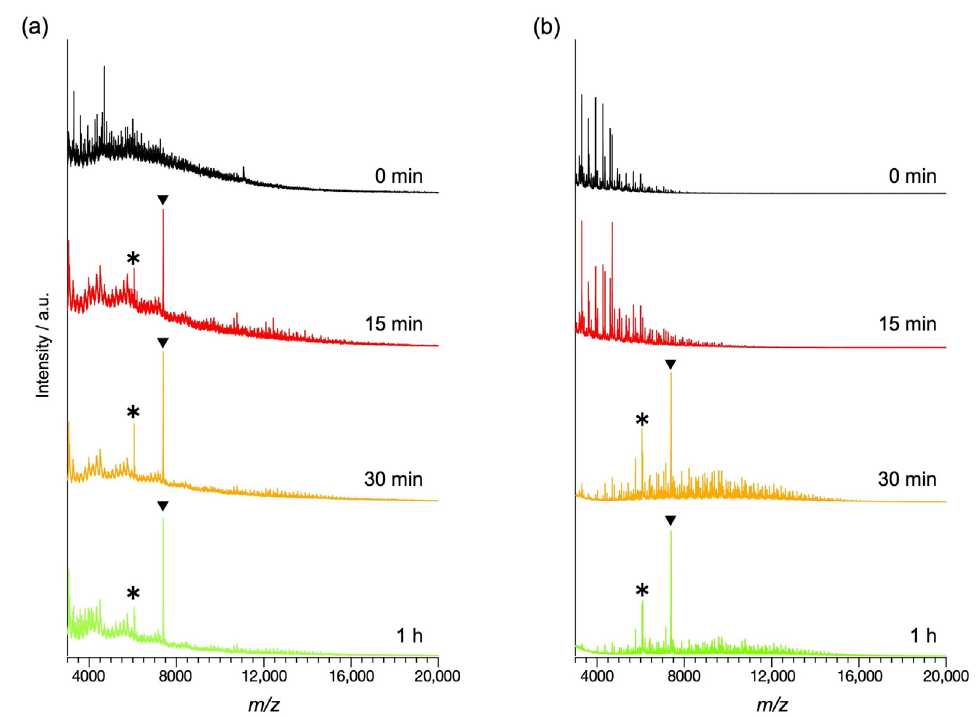
Figure 3. MALDI-TOF-MS spectra during Au 25 PET 18 synthesis ( a ) with TPM G4 and ( b ) without TPM G4. ▼ are the peaks of Au 25 PET 18 , and * is the fragment peaks. The same synthetic procedure was carried out without the dendrimer (Figure S6).